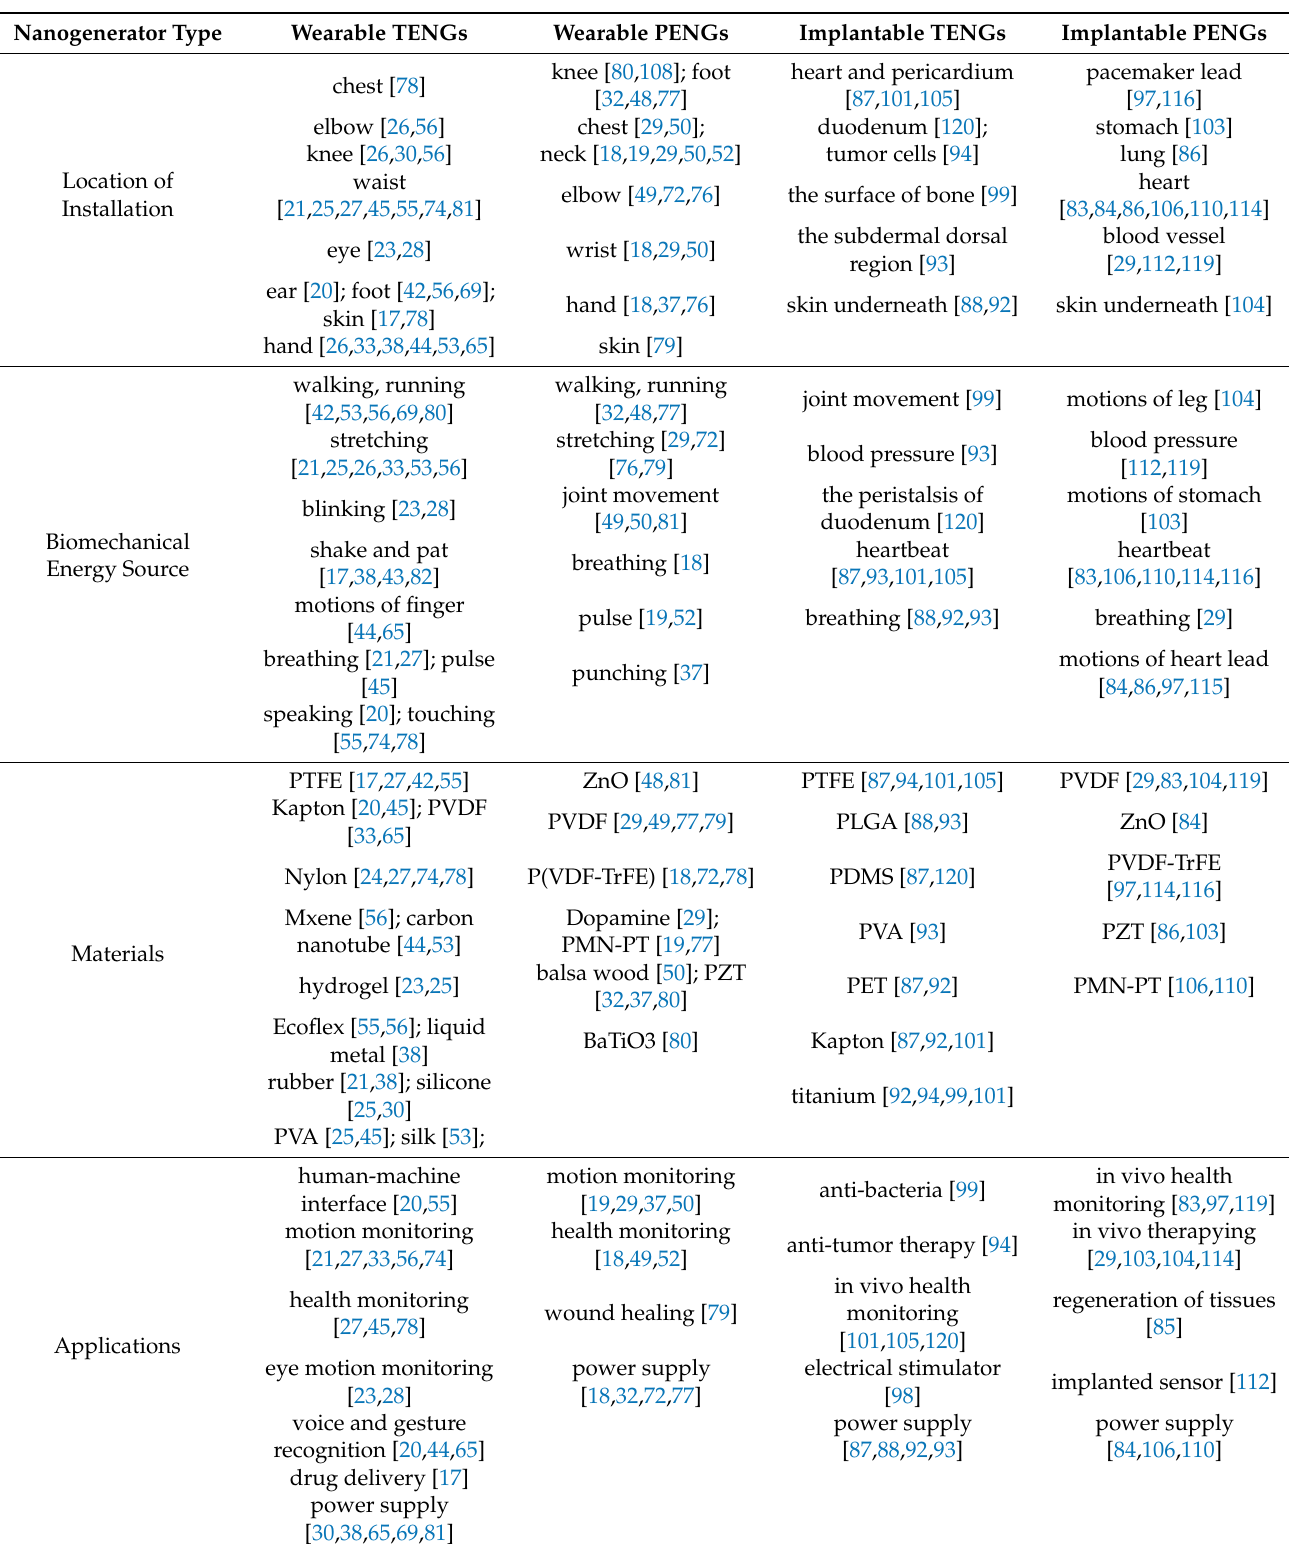
Table 1. Wearable and implantable TENGs and